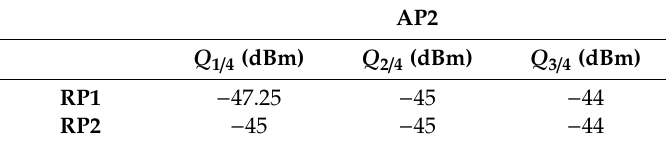
Table 2. Quartiles of the AP2 with RSSI measured in the RP1 and RP2.